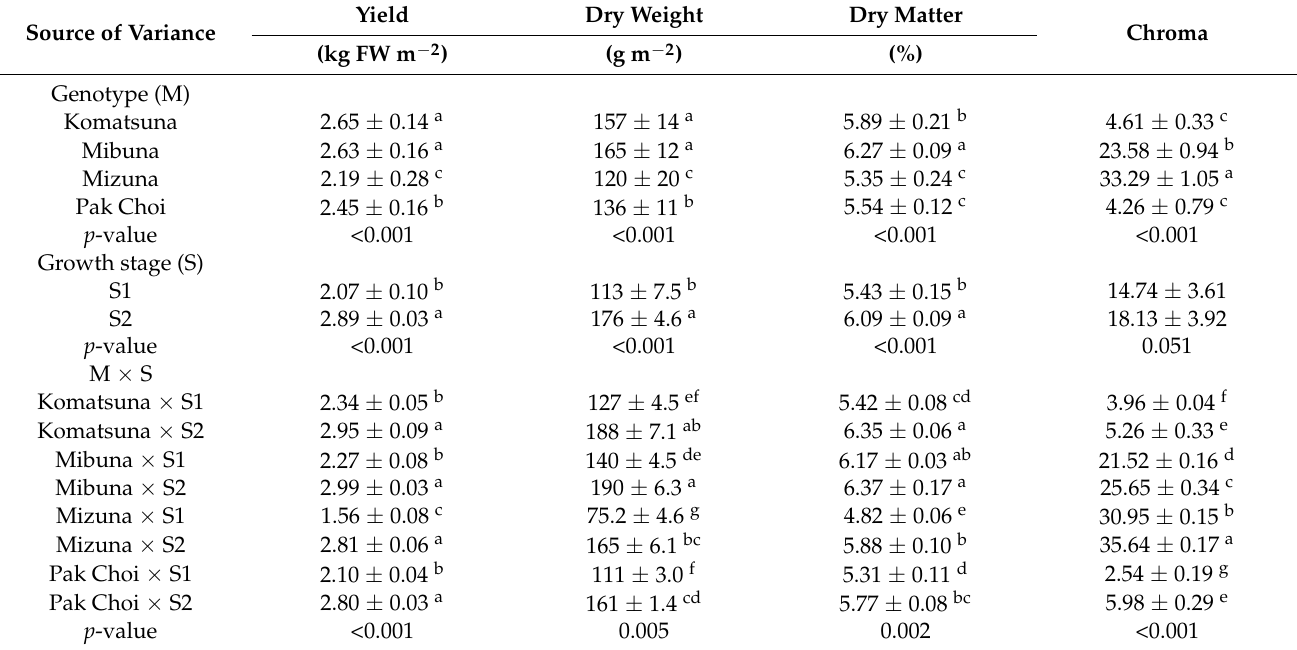
Table 1. Yield and colorimetric attributes of four Brassica rapa L. microgreens genotypes harvested at the first (S1) or second true-leaf stage (S2). All data are expressed as mean ± standard error, n =